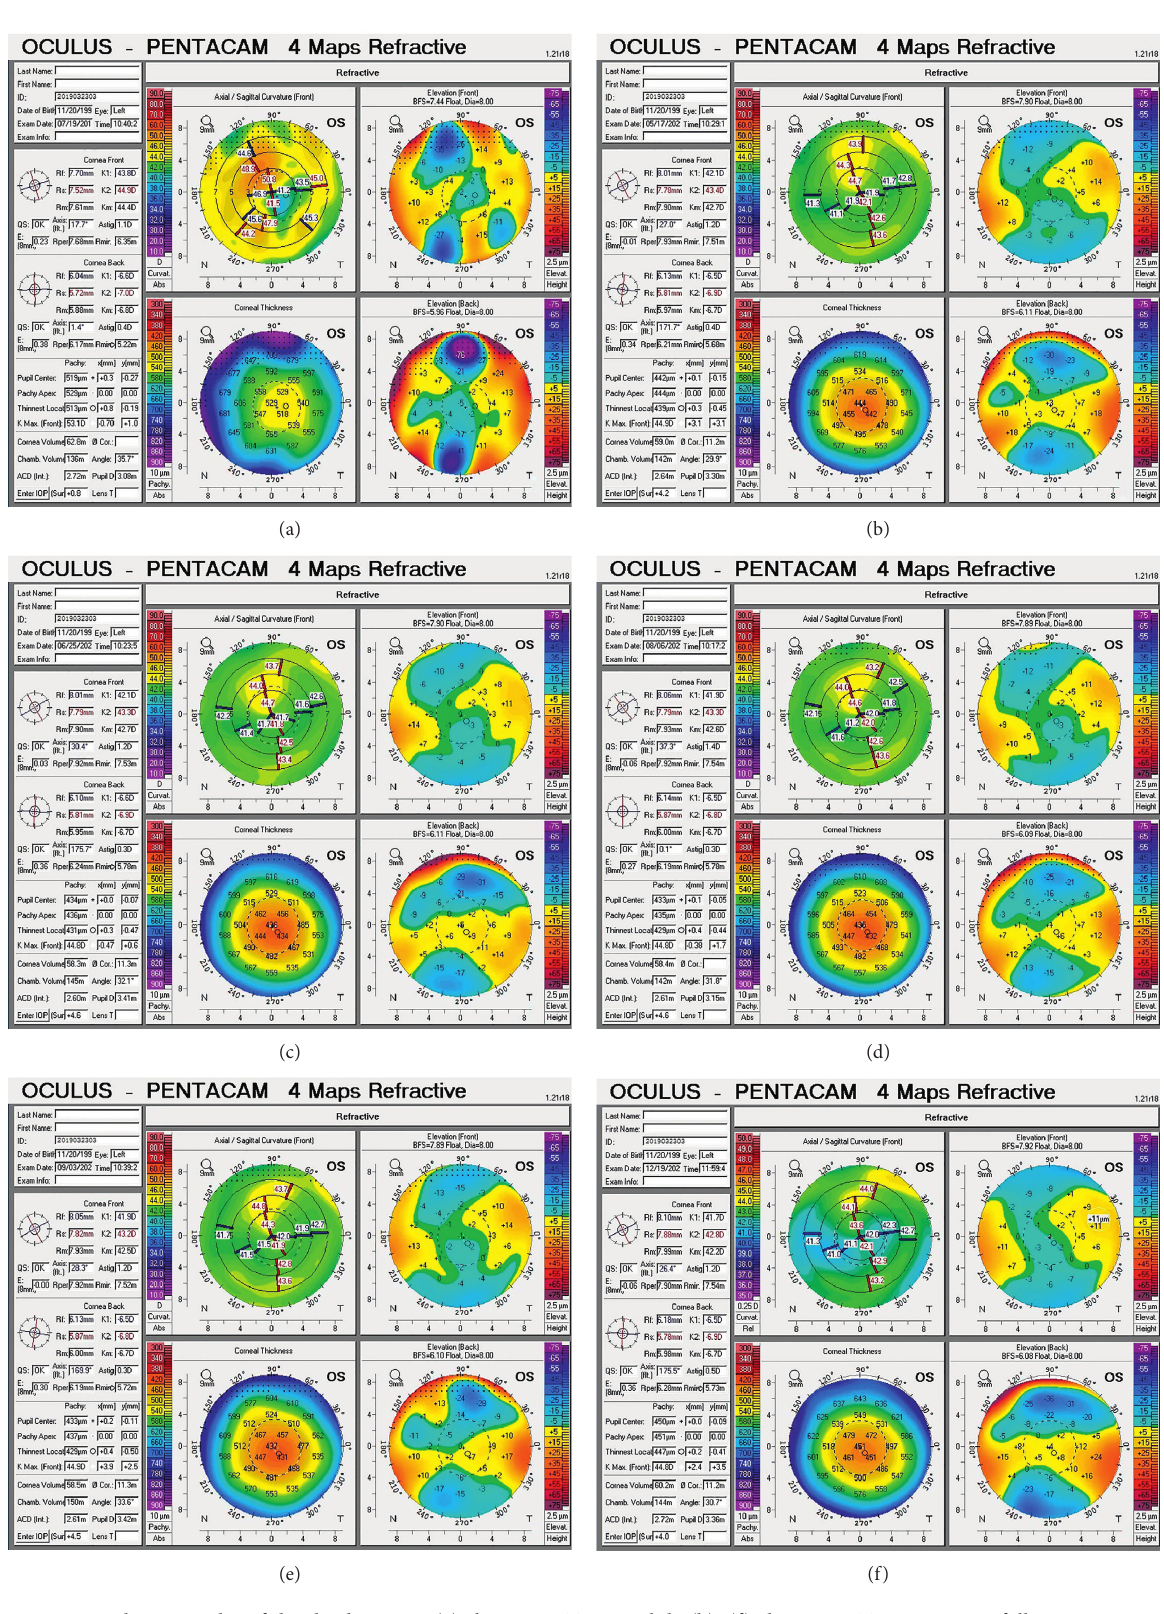
Figure 2: Corneal topography of the third patient. (a) shows pre-TPRK, while (b)–(f) show post-TPRK at some follow-up